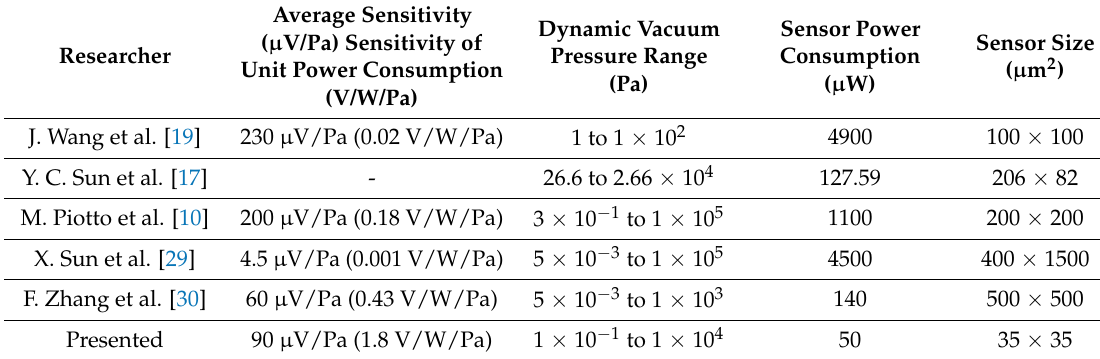
Table 2. Comparison of our work with some previous